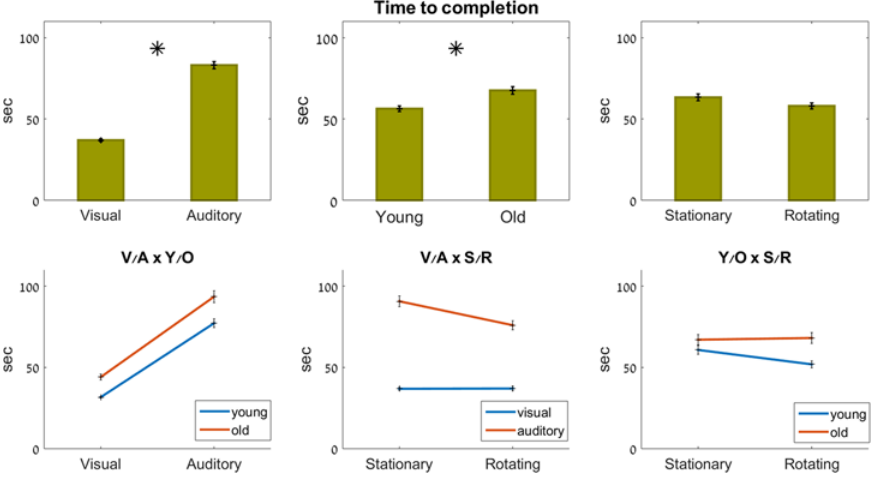
doi:10.1371/journal.pone.0151593.g004